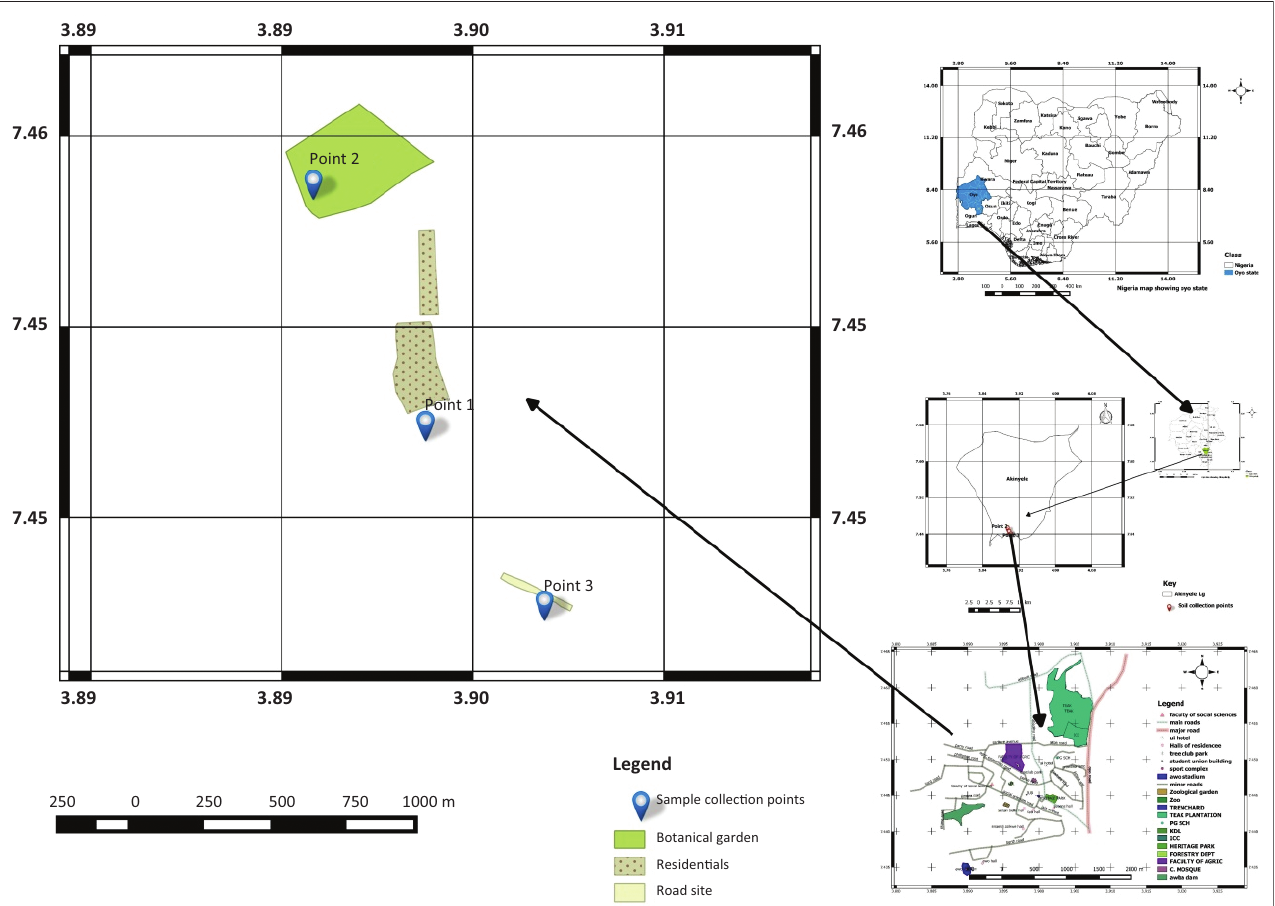
FIGURE 1: Map showing the three locations where samples of leaves were collected.